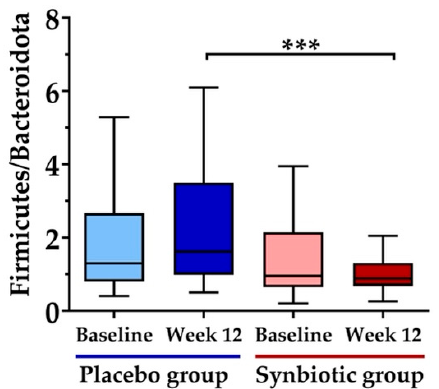
Figure 5. The effect of the 12-week synbiotic intervention on the Firmicutes/Bacteroidota (F/B) ratio in each experimental group was calculated using the relative abundance of bacteria. *** p < 0.001 com- pared to the placebo group at week 12.